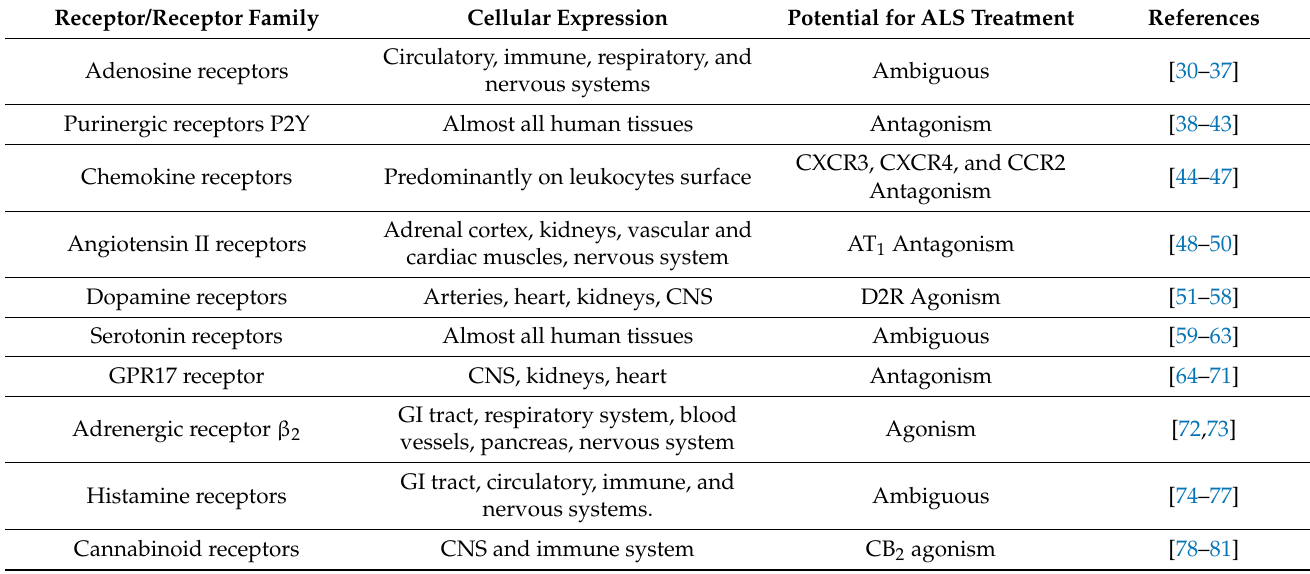
Table 2. Table summarizing the evidence about the therapeutic potential of the GPCRs examined in this article for ALS